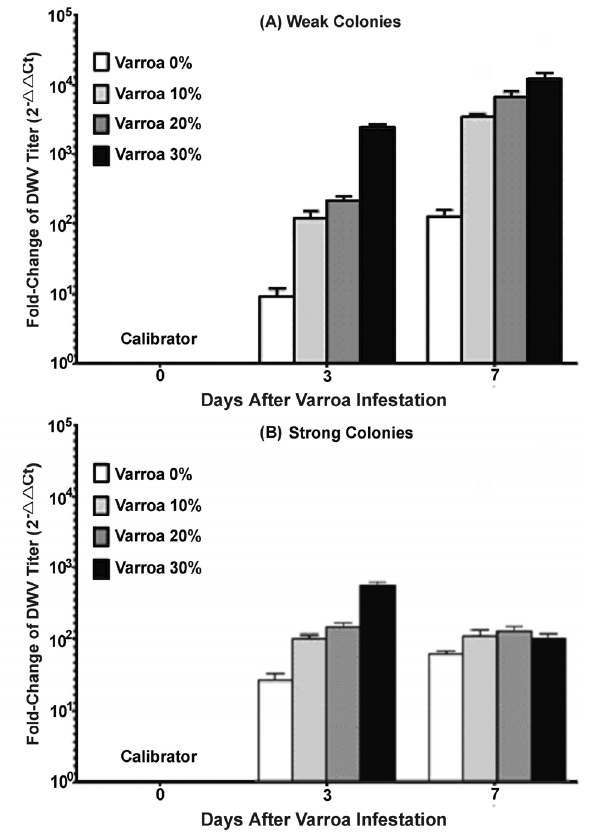
Figure 3. Relative quantitation of the DWV load in bees challenged by Varroa mites. ( A ) Bees originated from weak colonies. ( B ) Bee originated from strong colonies. Bees from strong and weak colonies were inoculated with variable levels of Varroa mites (0%, 10%, 20% and 30%) to induce the DWV infection and then compared the titers of the virus at different times after Varroa mite challenge. The bees collected at day 0 without transferring into rearing cups and exposing to Varroa mites were used as a negative control. While DWV was also detected in some bees in the negative control group, these had low levels of DWV infection. The virus level in other groups was expressed as an n-fold difference relative to the negative control group.